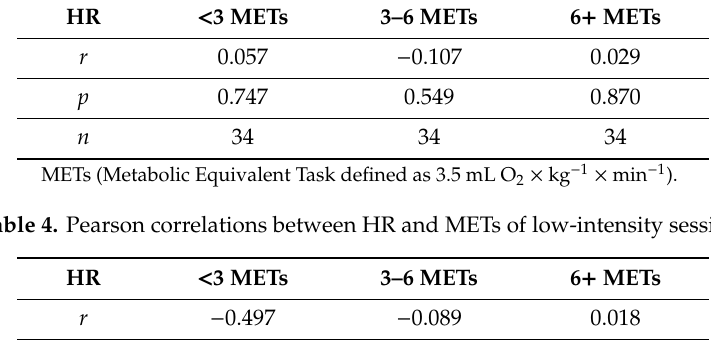
Table 3. Pearson correlations between HR and METs of moderate-intensity session. HR < 3 METs